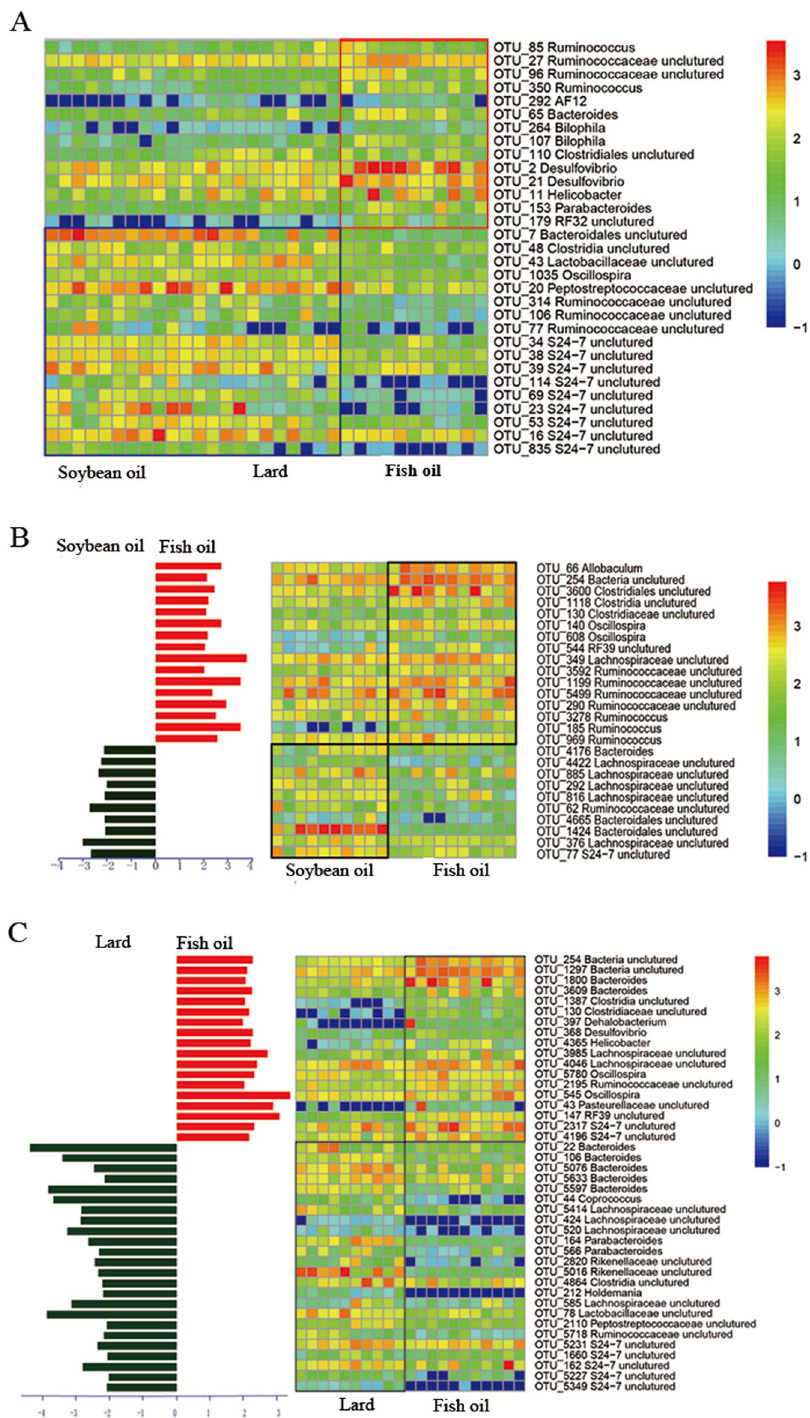
Figure 2. Comparisons of gut bacteria on OTU level using LefSe ( A ) caecal bacteria; ( B ) colonic bacteria between soybean oil and fish oil; ( C ) colonic bacteria between lard and fish oil. In B and C , the left histograms show the LDA scores computed for features on the OTU level. The middle heatmaps show the relative abundance of OTU (log 10 transformed). Each column represents one biological sample and each row represents the OTU corresponding to left